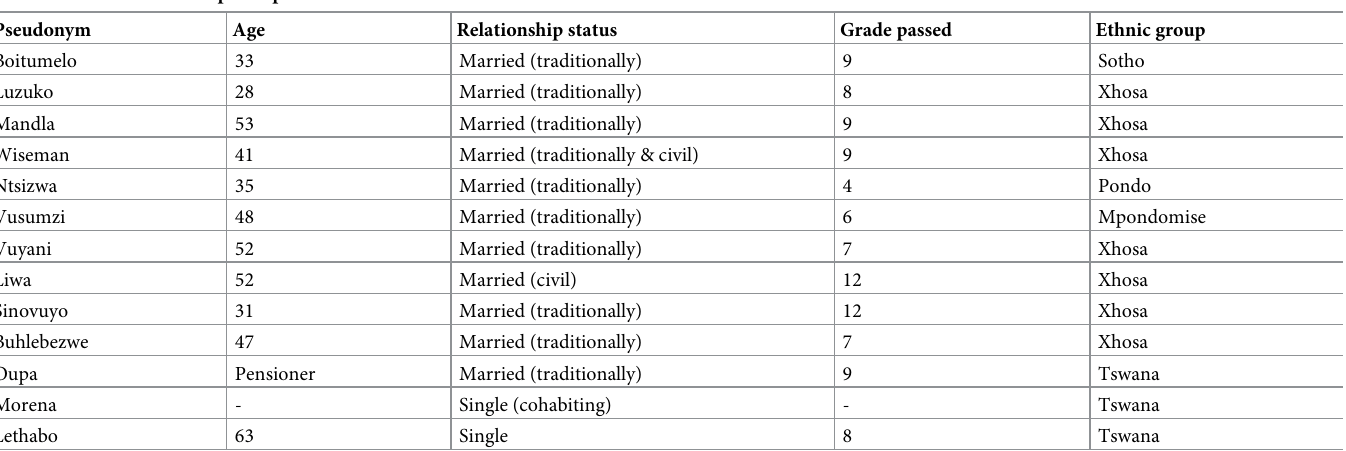
Table 1. Characteristics of